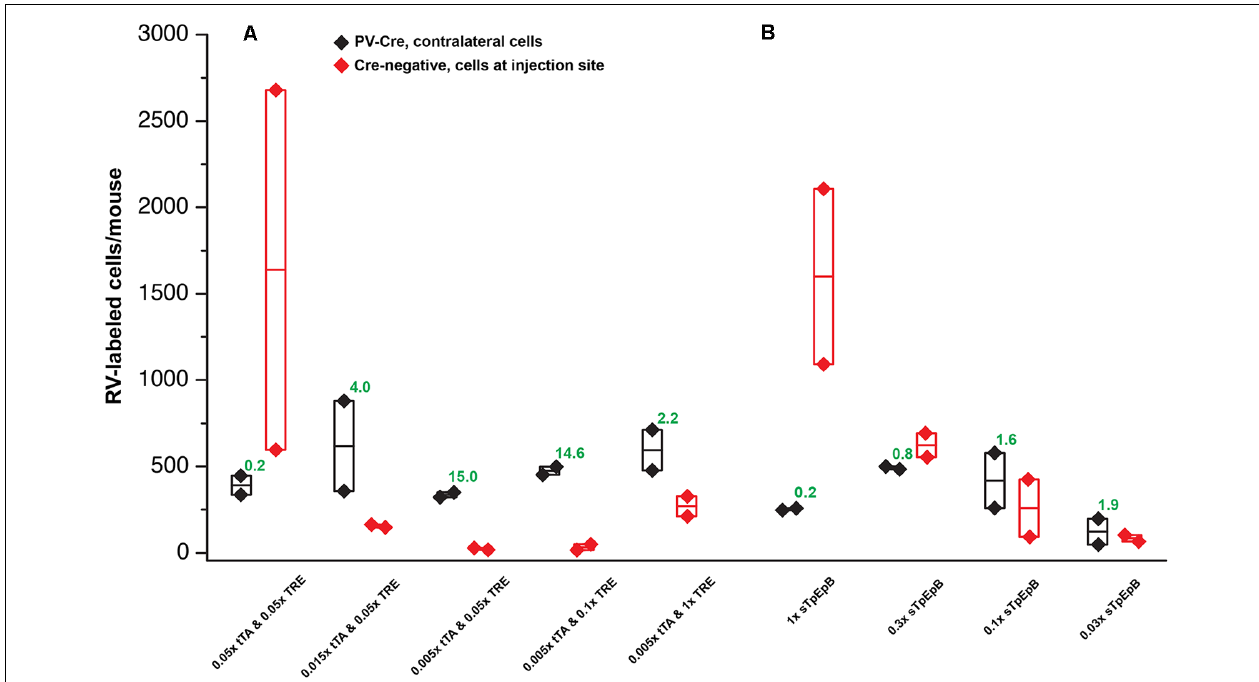
FIGURE 5 | Quantification of results in PV-Cre and Cre-negative mice: systematic dilution series. (A) Results of varying the concentrations of the two helper viruses in the tTA-TRE combination system. The highest ratio of contralateral neurons in Cre+ mice to ipsilateral neurons in Cre − mice was obtained with a 1:200 dilution of AAV1-syn-FLEX-splitTVA-EGFP-tTA and a 1:20 dilution of AAV1-TREtight-mTagBFP2-B19G (“0.005 × tTA and 0.05 × TRE” in the figure). (B) Results of varying the concentration of the single helper virus AAV1-syn-FLEX-splitTVA-EGFP-B19G. Higher dilutions (out to 1:33.3) give higher ratios of contralateral neurons in Cre+ mice to ipsilateral neurons in Cre − mice, but results with the single-helper approach were nowhere near as good as with the two-helper combination. n = 2 for all conditions. Diamonds represent cell counts from individual mice; the middle lines in the boxes represent the average count for each condition. Source numbers are provided in Supplementary Table S2